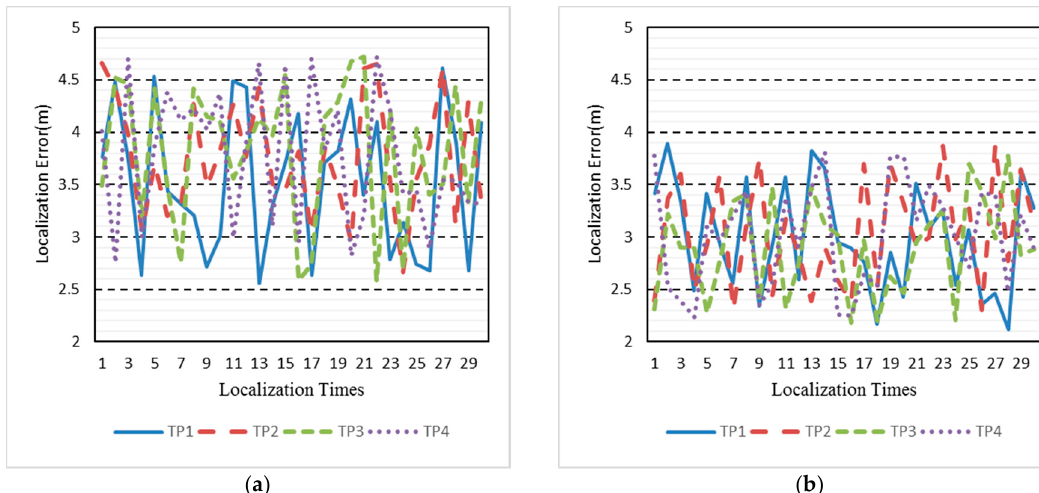
Figure 8. Localization error before ( a ) and after ( b ) radio map renovation.